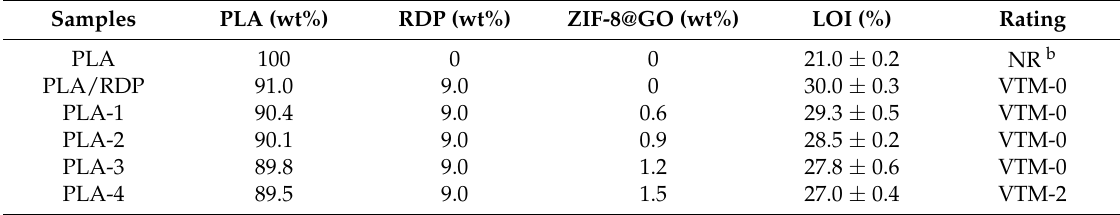
Table 1. Formulations and combustion tests of nanocomposite